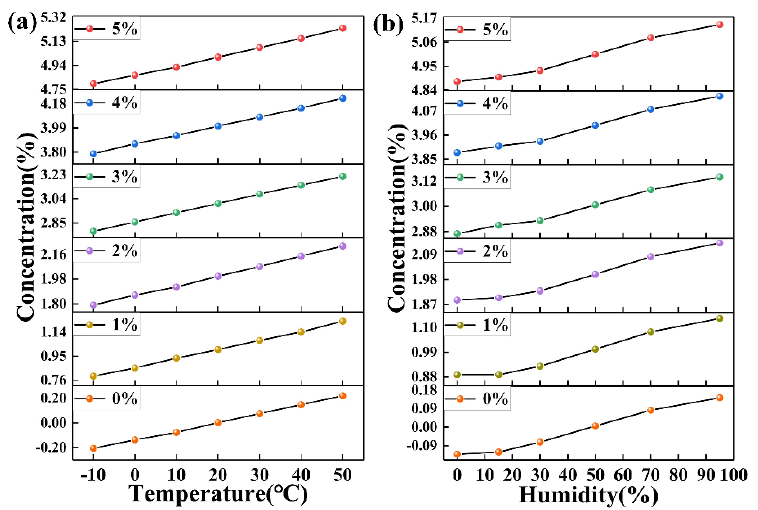
Figure 6. Actual concentration measurements of standard gases at ( a ) different temperatures and ( b ) humidity without concentration compensation.